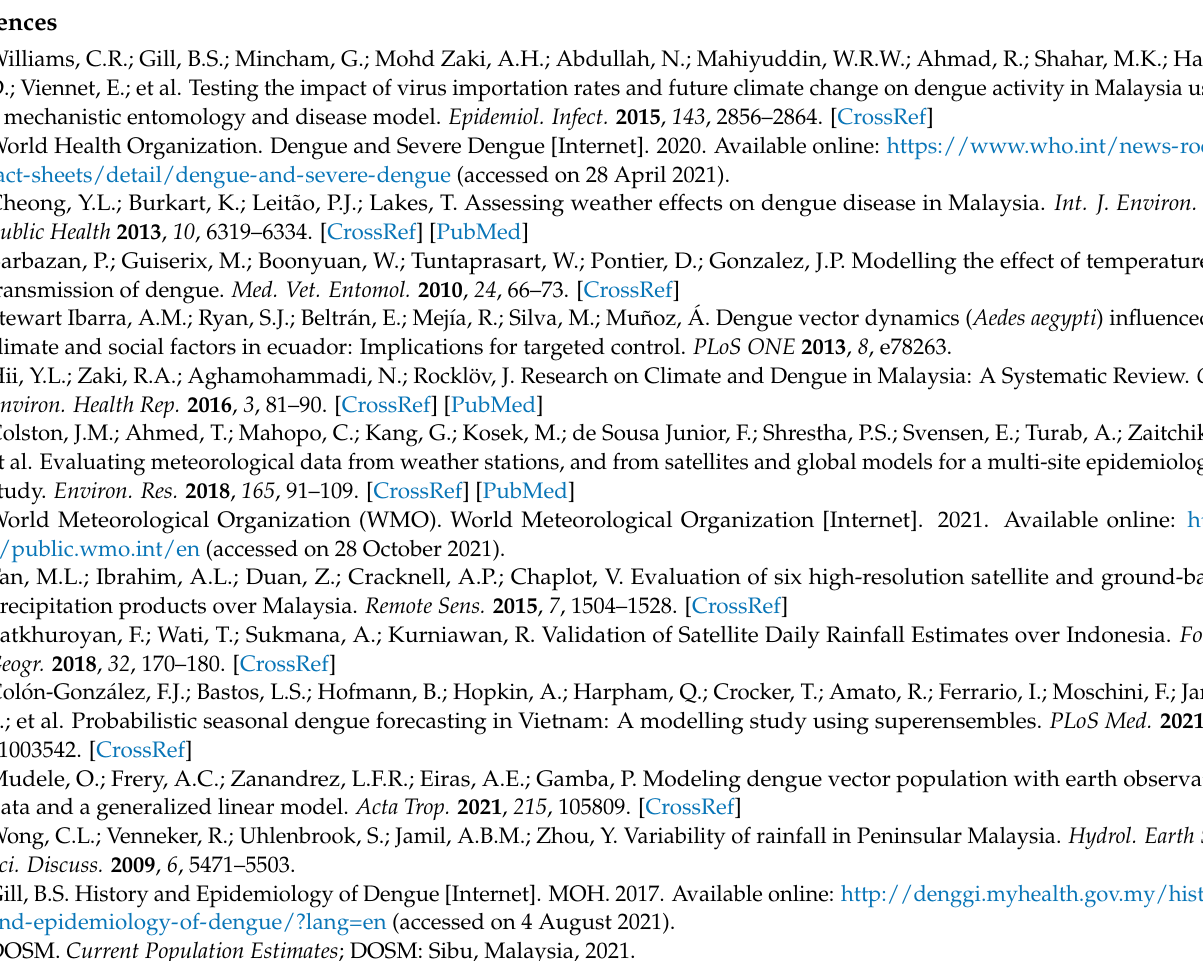
Figure A5. Scatter plot of predicted value and residuals.